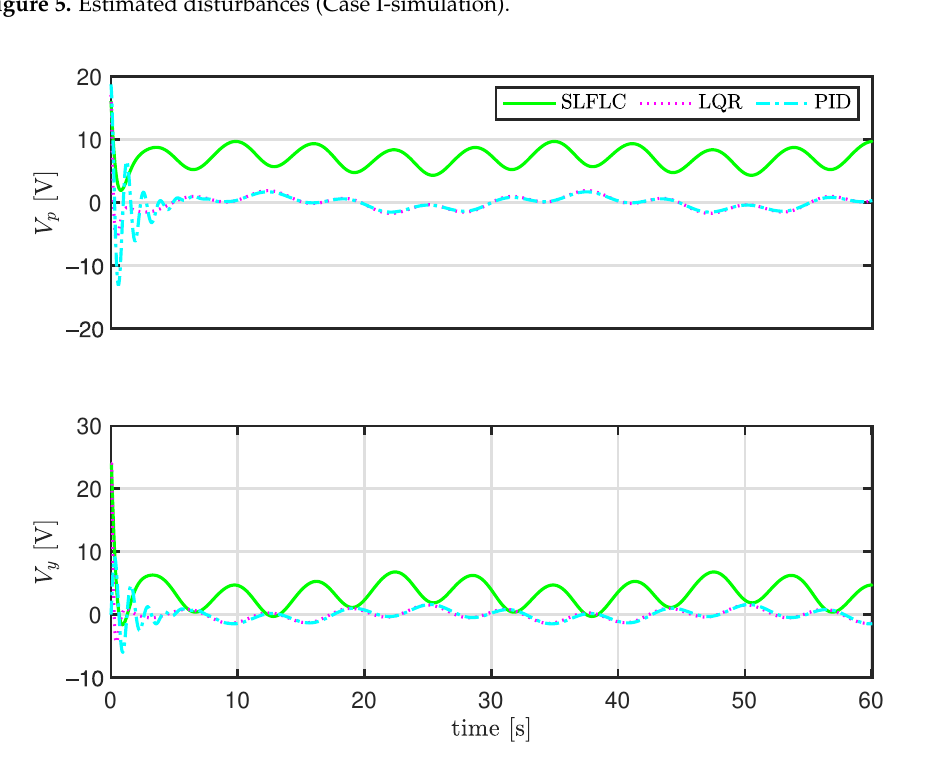
Figure 6. Input voltages (Case